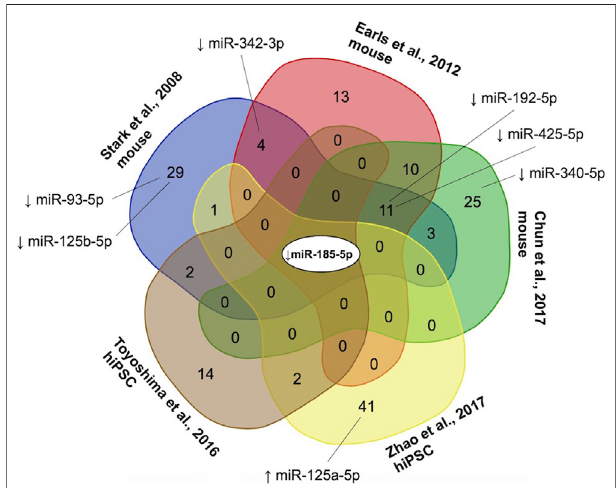
FIGURE 3 | Convergence of microRNAs (miRNAs) reported as differentially expressed in three mouse model studies (Stark et al., 2008; Earls et al., 2012; Chun et al., 2017) and two human induced pluripotent stem cell models (Zhao et al., 2015; Toyoshima et al., 2016) of the 22q11.2 deletion. Collectively, 156 miRNAs were reported as differentially expressed (usingvarious criteria), of which 122(78.2%) were downregulated, 40 (25.6%) upregulated, and 6 (3.8%) up-or down-regulated in different studies. The only miRNAdownregulatedinall fi vestudieswasmiR-185-5p,aconservedmiRNA located within the proximal 22q11.2 deletion region (Guna et al., 2015). miRNAs with targets that were found to be overlapped by one or more rare genome-wide CNVs in signi fi cantly more individuals with 22q11.2 deletion syndrome in the schizophrenia than non-psychotic group in the current study are shown with a black line connecting to the studies reporting differential miRNA expression. ↑ , increased expression; ↓ , decreased